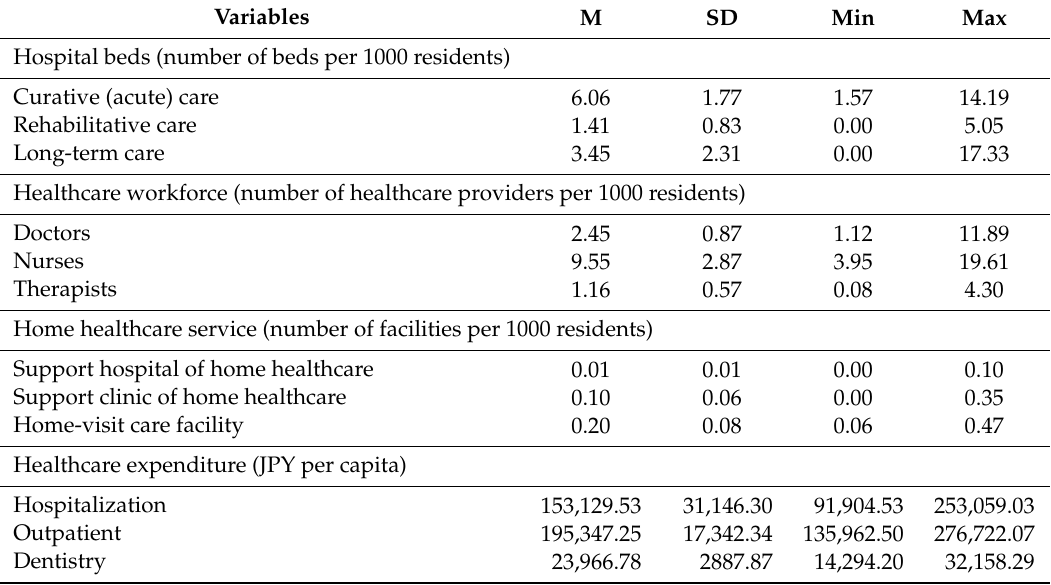
Table 2. Descriptive statistics of healthcare resource variables.